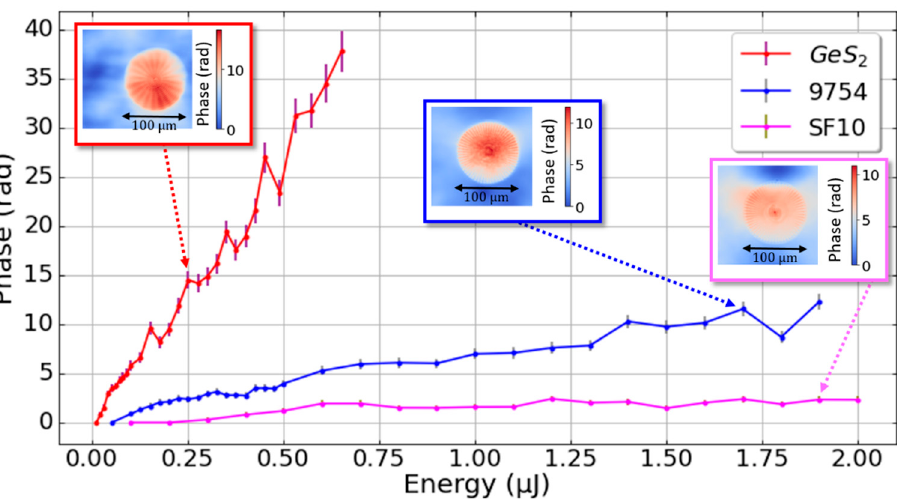
Figure 2. Phase variation implemented by the FLDW technique as a function of laser energy. The writing speed of these irradiations is fixed at 1 mm/s (corresponding to about 120 pulses/ µ m). Inset: an example of a quantitative phase map measured by the Quantitative Phase Microscopy technique has been added for each material. Laser parameters: 1030 nm, 800 fs, 100 kHz, and 0.6